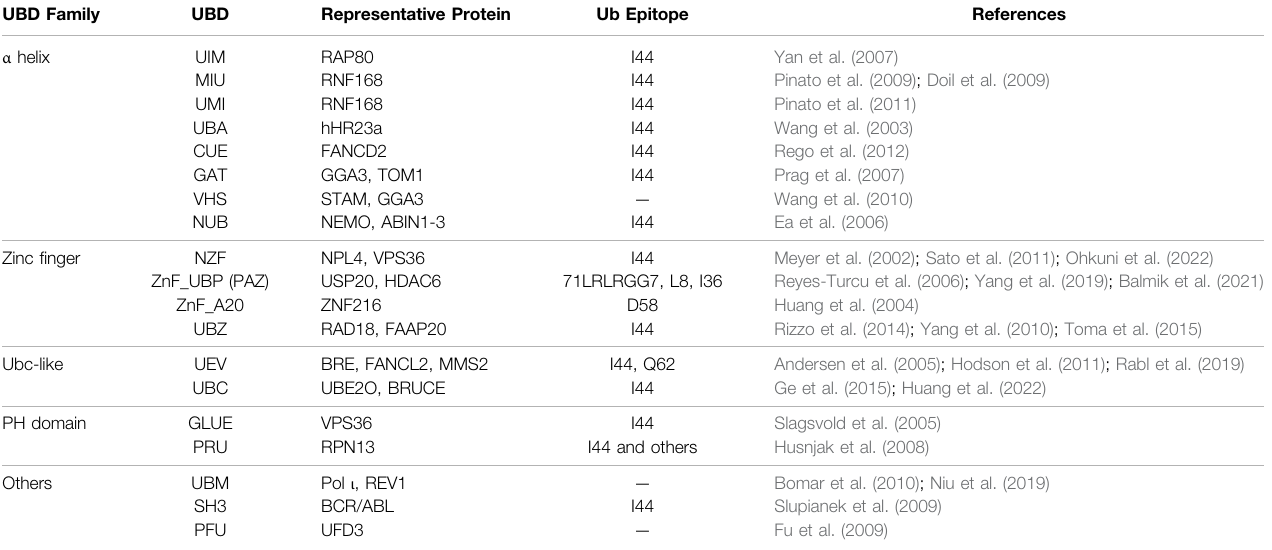
TABLE 2 | Ubiquitin-binding